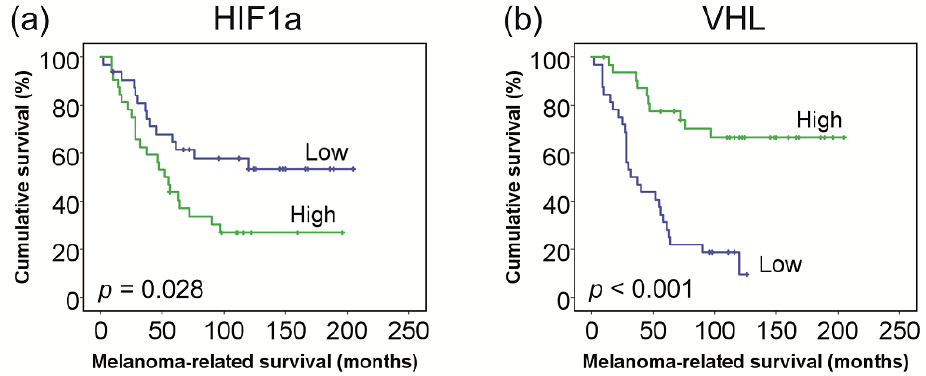
Figure 1. Patient survival in relation to messenger RNA (mRNA) gene expression of ( a ) hypoxia-inducible factor 1-alpha (HIF1a) and ( b ) von Hippel–Lindau (VHL). Groups (high vs. low) were based on the median mRNA gene expression values ( n = 64).